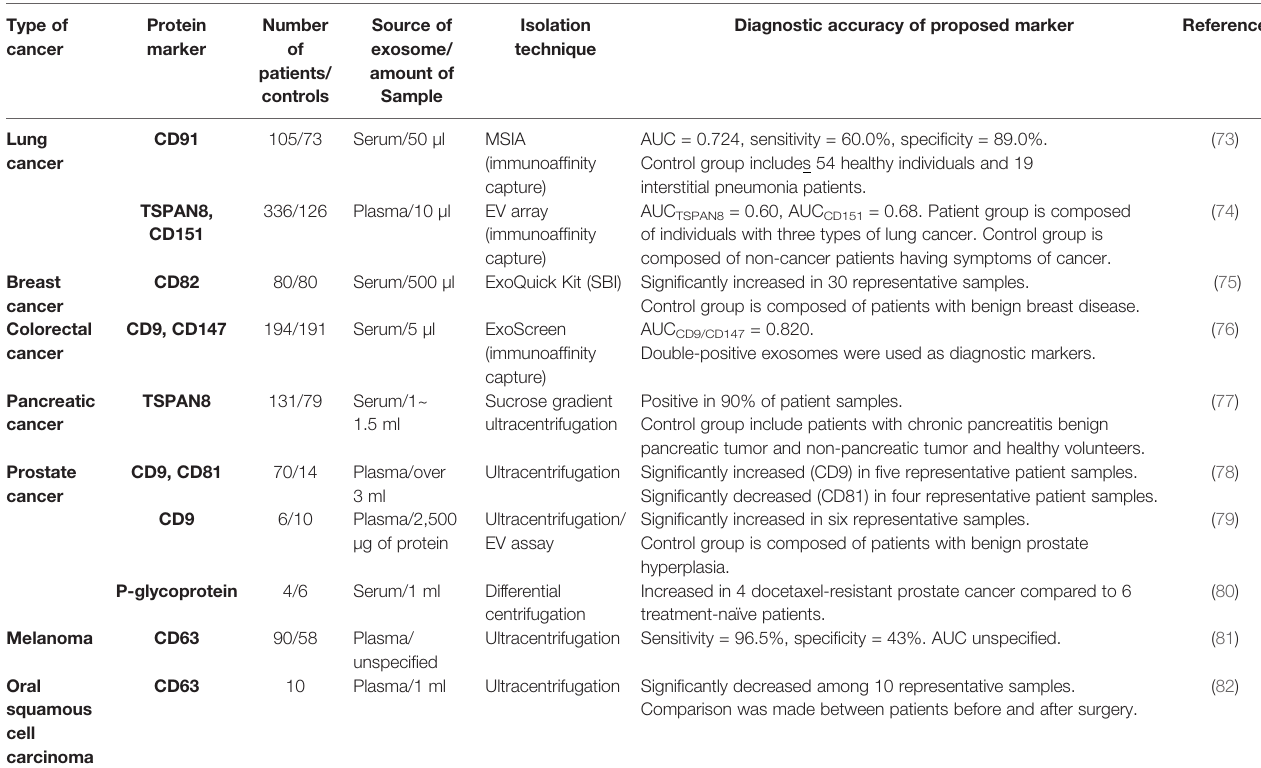
TABLE 3 | Exosomal tetraspanin and surface markers. Type of cancer